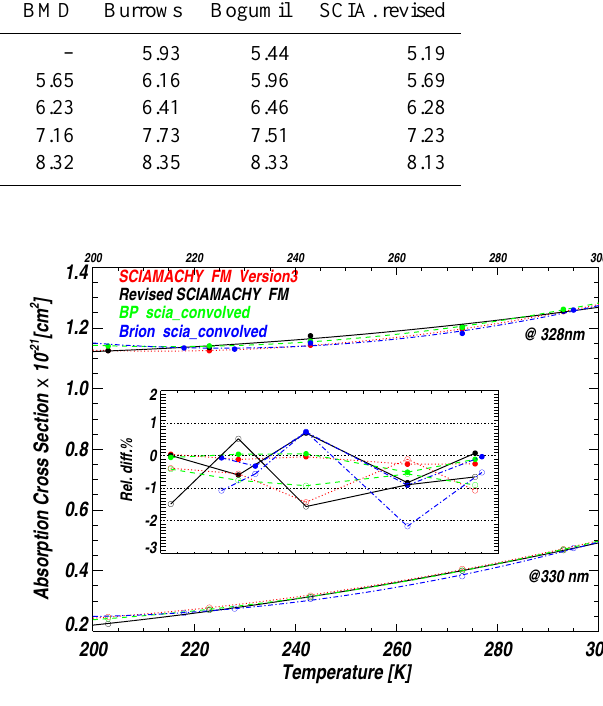
Fig. 9. Comparison of measured (solid and open circles) and pa- rameterized (lines) absorption cross sections of SCIAMACHY FM and literature data convolved to SCIAMACHY spectral resolution at 328 and 330nm. The differences between both are shown in the